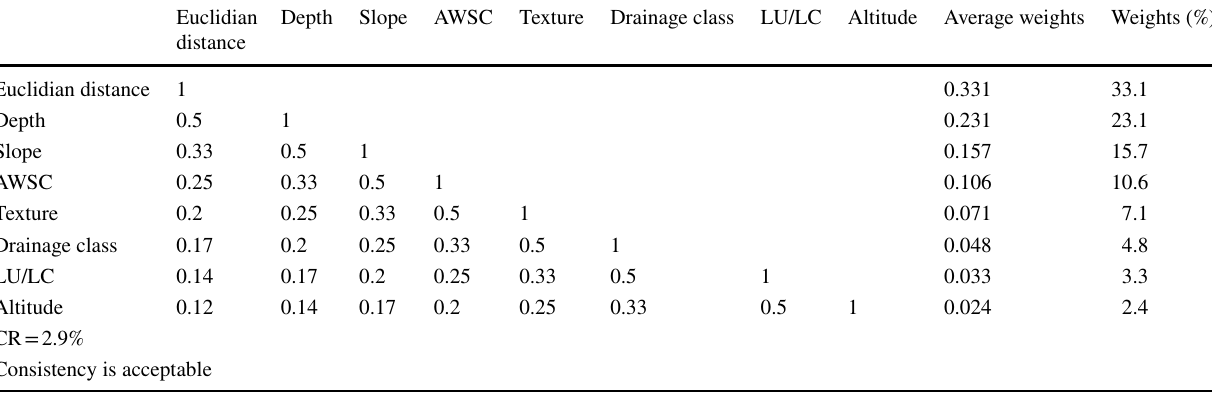
Table 7 Pairwise comparison matrix for assessing the relative relevance of eight